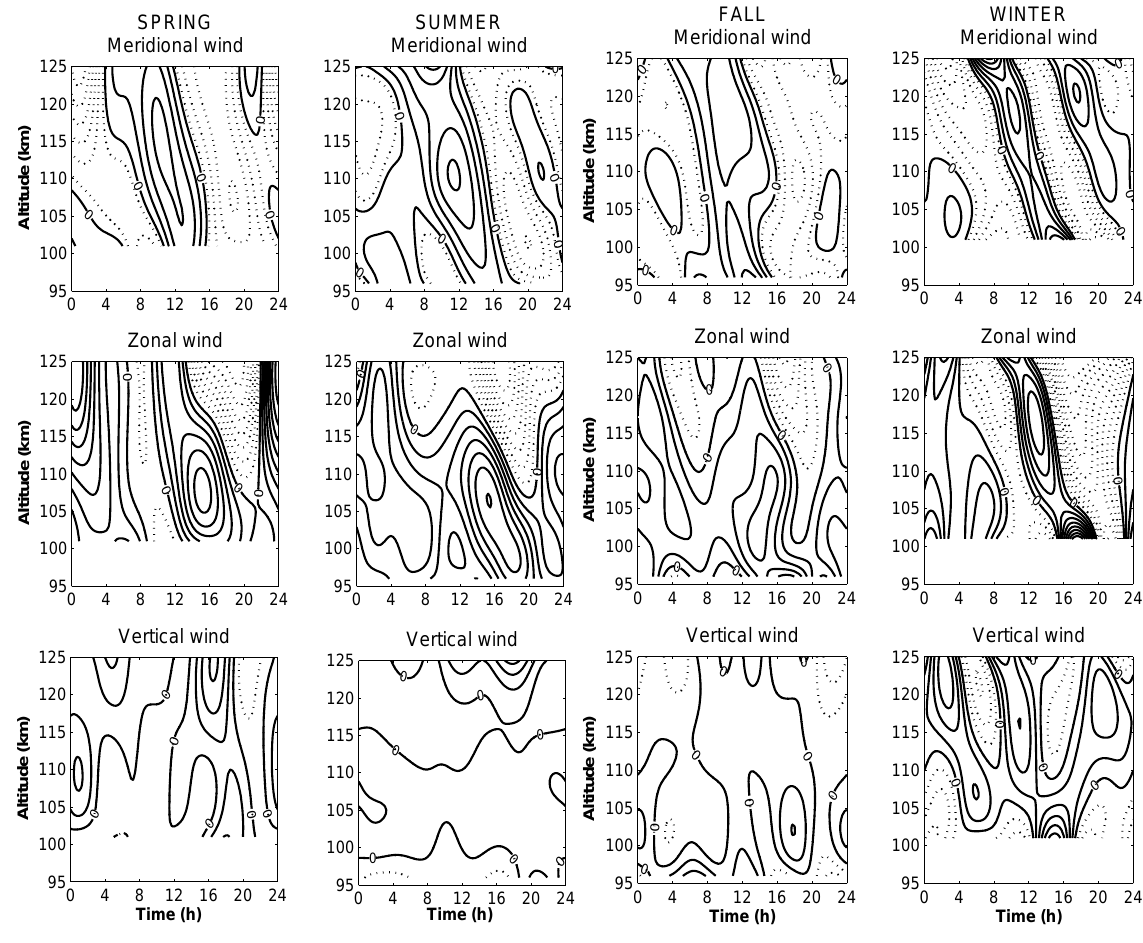
Fig. 1. Diurnal variation of the wind components for spring, summer, fall and winter. The spacing interval between lines is 20m/s for the horizontal components and 5m/s for the vertical component. Continuous lines for positive (eastward, northward, up) values, dotted lines for negative values (in spring and winter the lowest height where data were available was